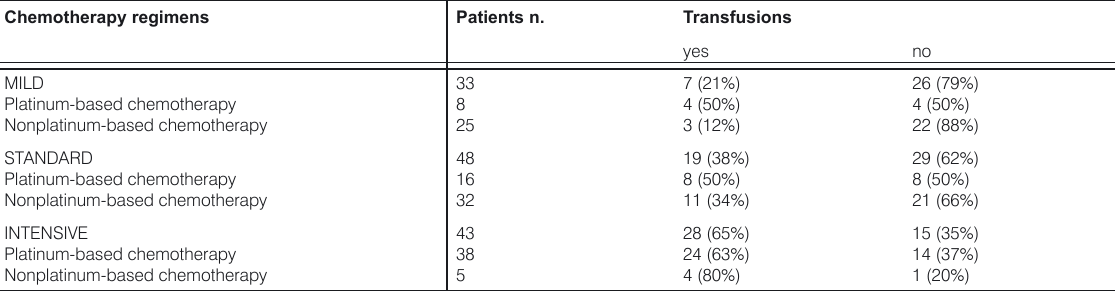
Table 6. Platinum administration and frequency of transfusions.